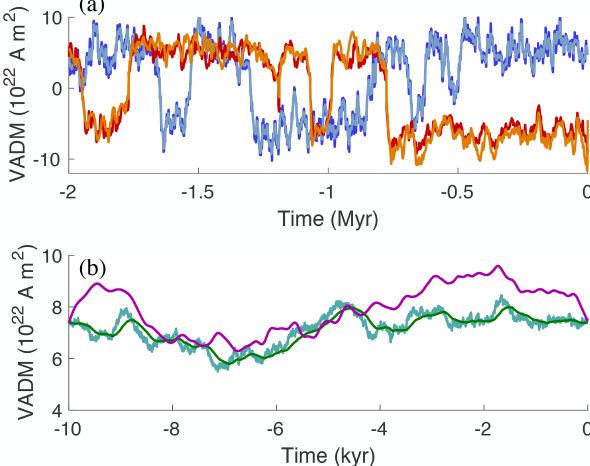
Figure 2. Simulations with nominal parameter values and data on the Myr and kyr scales. (a) VADM as a function of time on the Myr timescale. The output of the Myr model, x Myr , is shown in dark j , is shown in light blue (often hidden). The smoothed output, x Myr , s j blue. The signed Sint-2000 and PADM2M are shown in orange and red with signs (reversal timings) taken from Cande and Kent (1995). (b) VADM as a function of time on the kyr timescale. The output of the kyr model with uncorrelated noise is shown in turquoise. The output of the kyr model with correlated noise is shown in green. VADM of CALS10k.2 is shown in